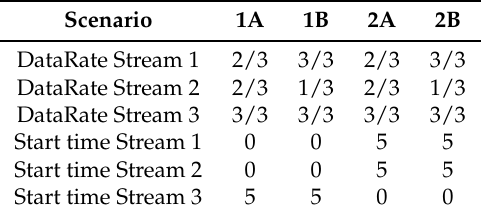
Table 4. Simulation scenarios summary for multiple stream simulations.